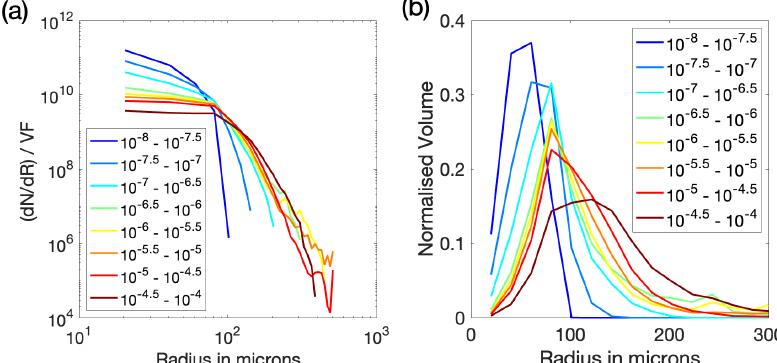
Figure 4. The 1s bubble size distributions for all deployments were sorted by void fraction into the ranges shown in the legend. Panel (a) shows the mean bubble size distributions for each void fraction range plotted as bubble number per micrometre radius incre- ment per unit volume, normalised by the individual void fraction (d N / d R ) / VF (m − 3 , µm − 1 ) . (b) The same data plotted as normalised volume. Each bubble size distribution in a given range was normalised by its own volume and the mean of the resulting distributions is shown